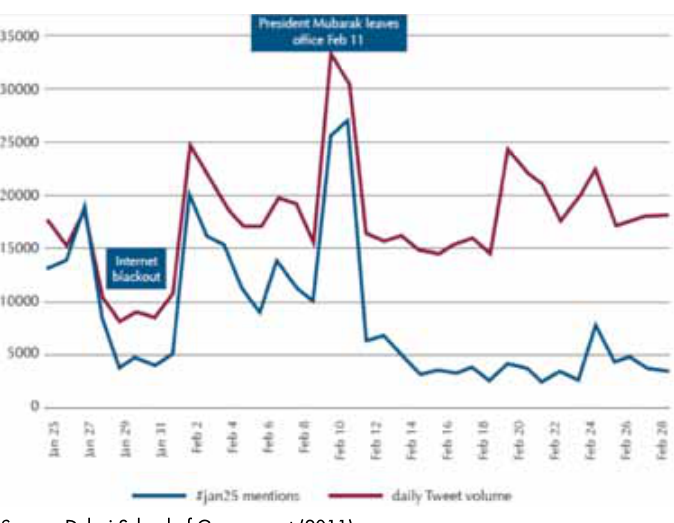
Source : Dubai School of Government